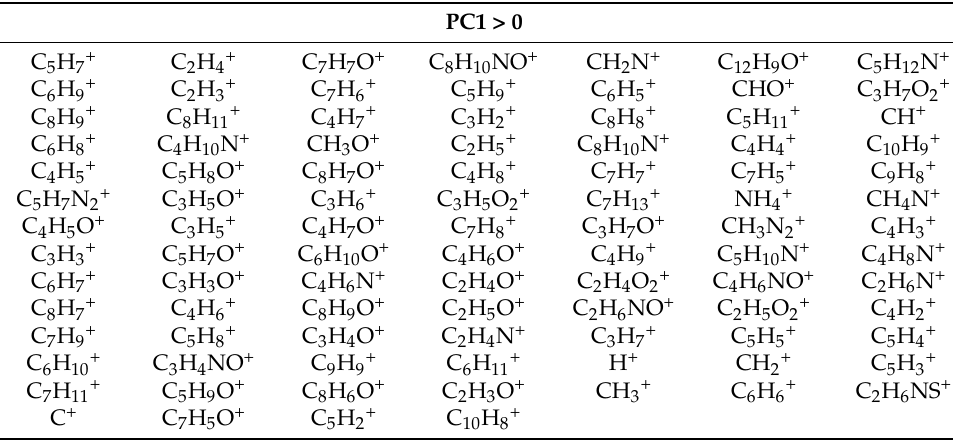
Table 3. PC1 loadings list related to the functionalized AuNP/VEGF Cys FAM.